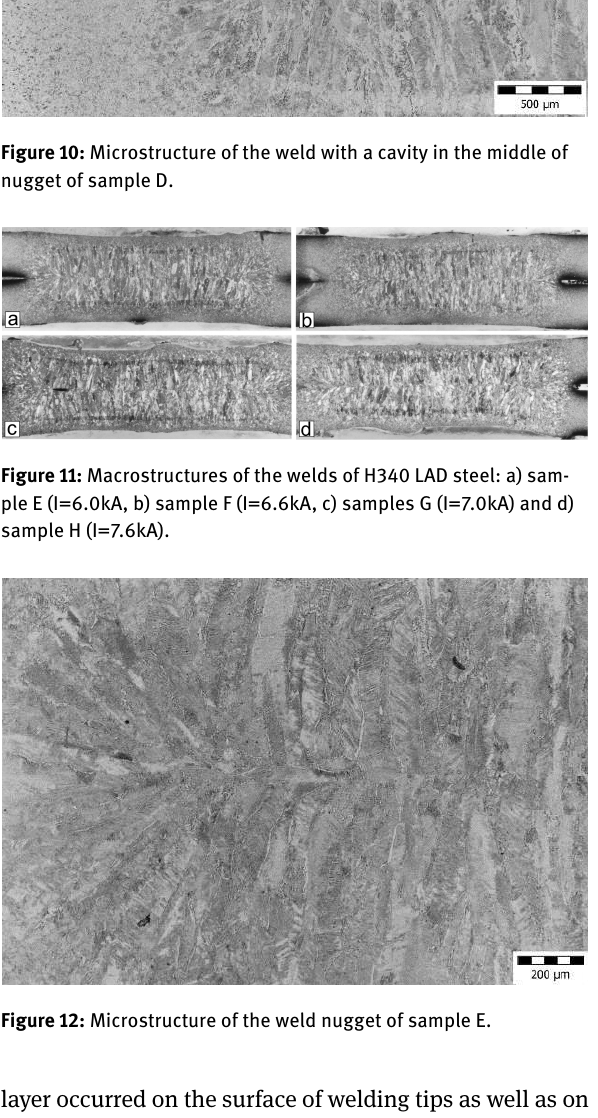
layer occurred on the surface of welding tips as well as on the zinc surface of welded sheets and has a negative effect on the contact resistance in the welding process. Because of a high welding temperature (906 ∘ C) and pressure, zinc evaporates from the welding area. On the other hand, if the temperature is lower (about 420 ∘ C), zinc melts and then adheres to welding tips. When thin brass layer is formed, it is forced out to the weld’s perimeter.